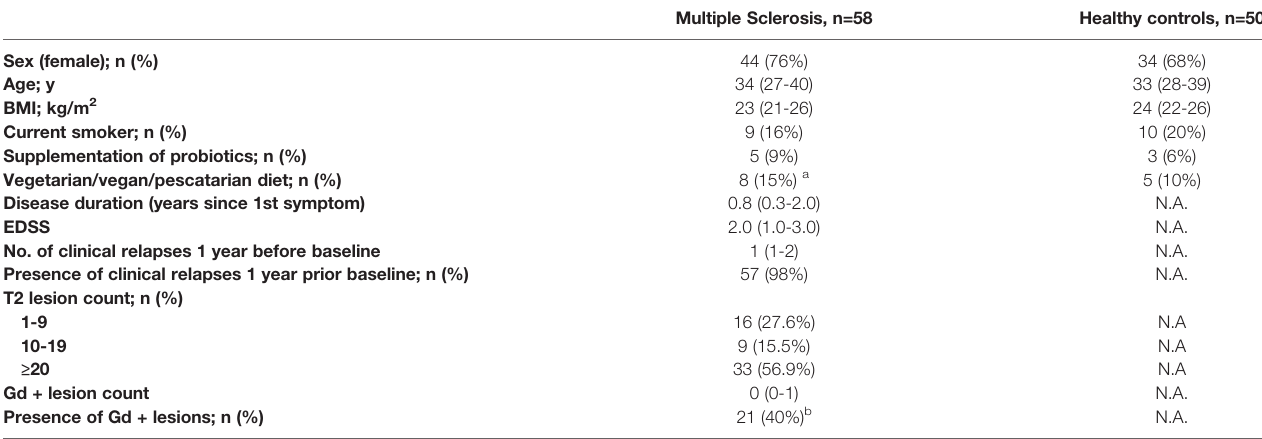
TABLE 1 | Demographics and clinical